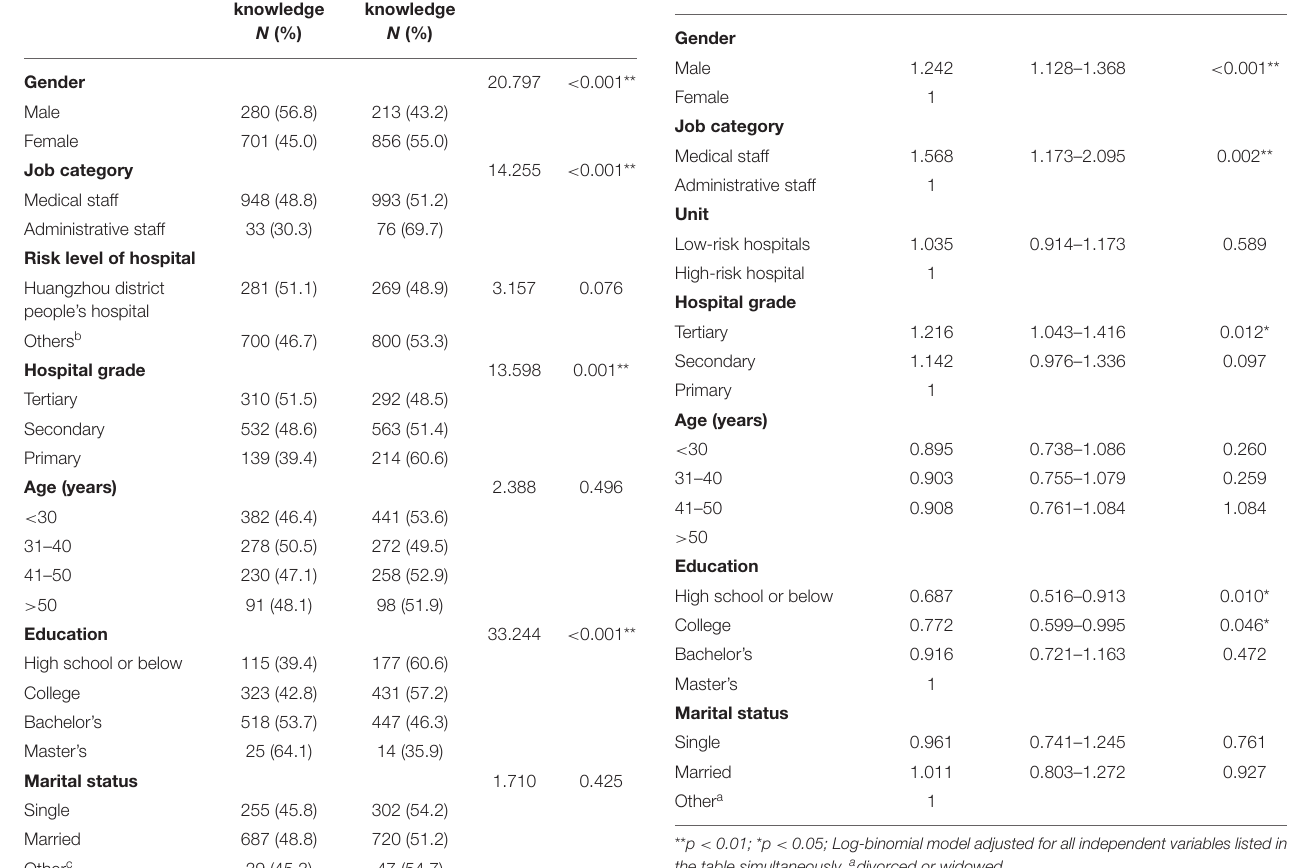
TABLE 2 | Association between HCWs’ COVID-19 knowledge a and their characteristics. Variables